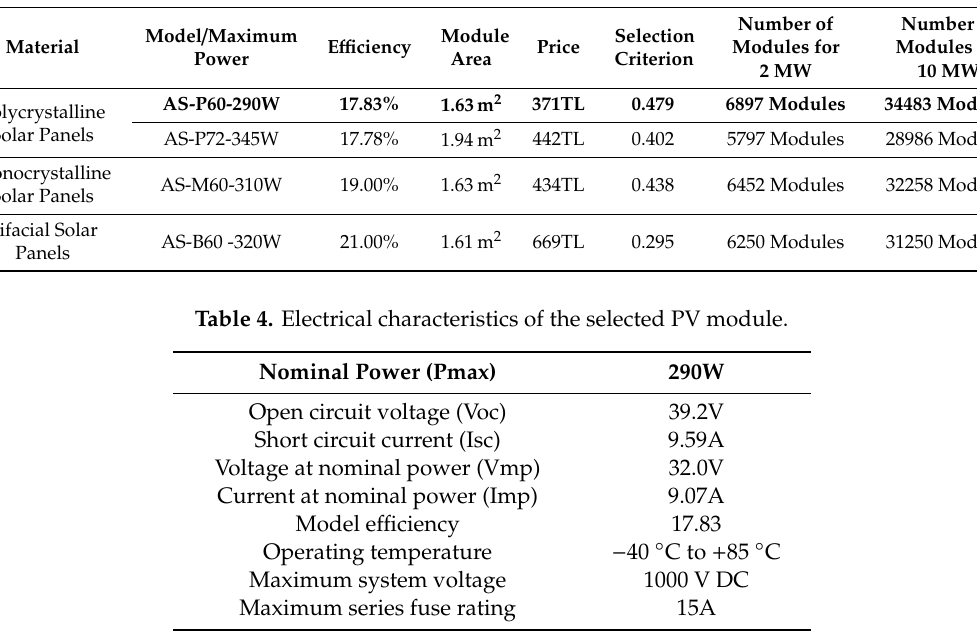
Table 3. Specifications of best PV modules from the Ankara Solar company [53].